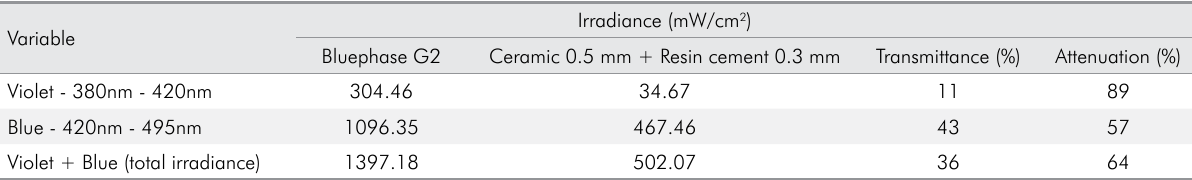
Table 3. Light irradiance (mW/cm 2 ) transmittance (%) and attenuation (%) through ceramic veneer and resin cement.